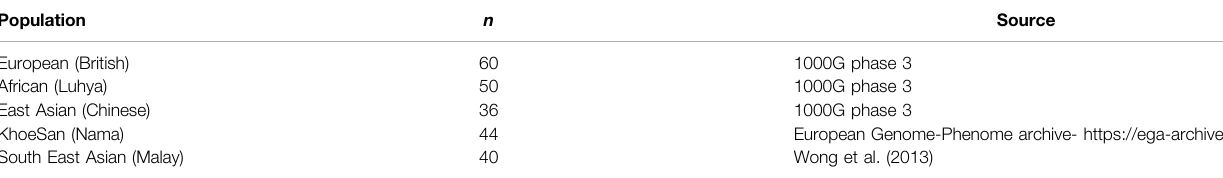
TABLE 1 | Ancestral populations included in